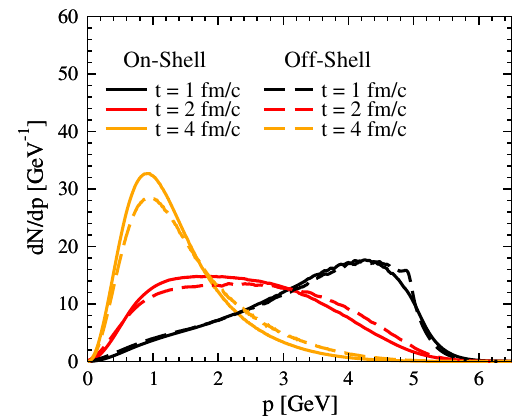
Fig. 12 Time evolution of the charm quark momentum distribution in athermalbulkat T = 0 . 2 GeV.Solidlinesarefortheon-shelldynamics while dashed lines are for off-shell dynamics. Different colors are for different times. For the off-shell case in this calculation γ ∗ and the energy density of the bulk is the same to the on-shell case